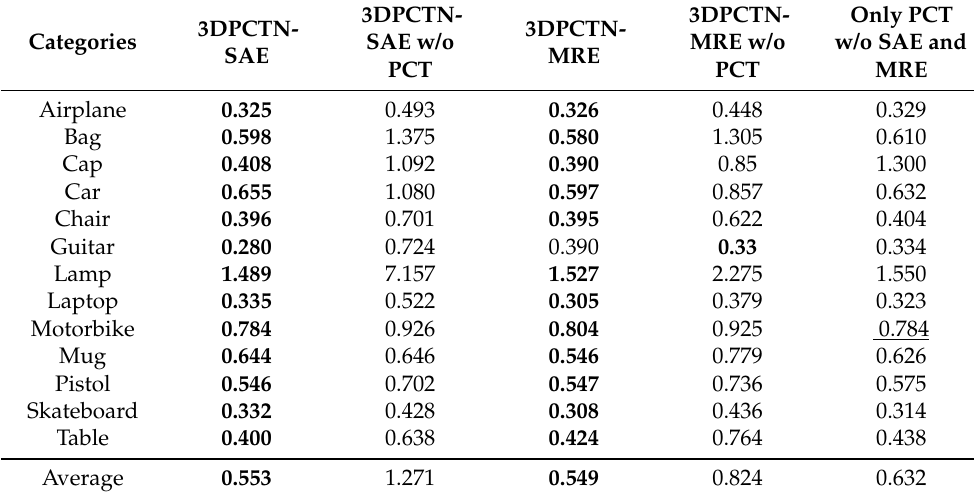
Table 3. Quantitative comparison between our method and the ablated versions on ShapeNet-Part dataset using chamfer distance (CD × 1000) with 2048 points. The best results are highlighted in bold and underlined. The lower results are the